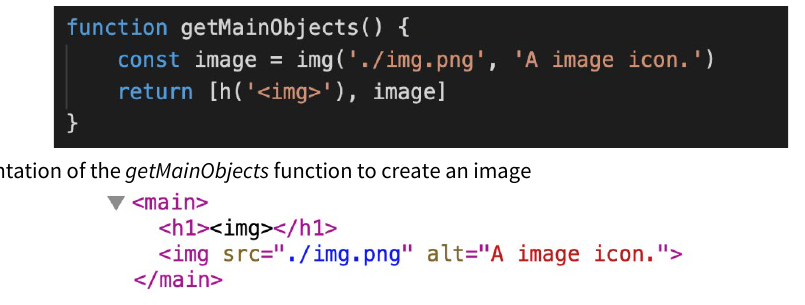
Figure 10. HTML code generated for the implementation of the getMainObjects function returning an image. The second attribute from the img function is used as the value of the alt property for the  tag